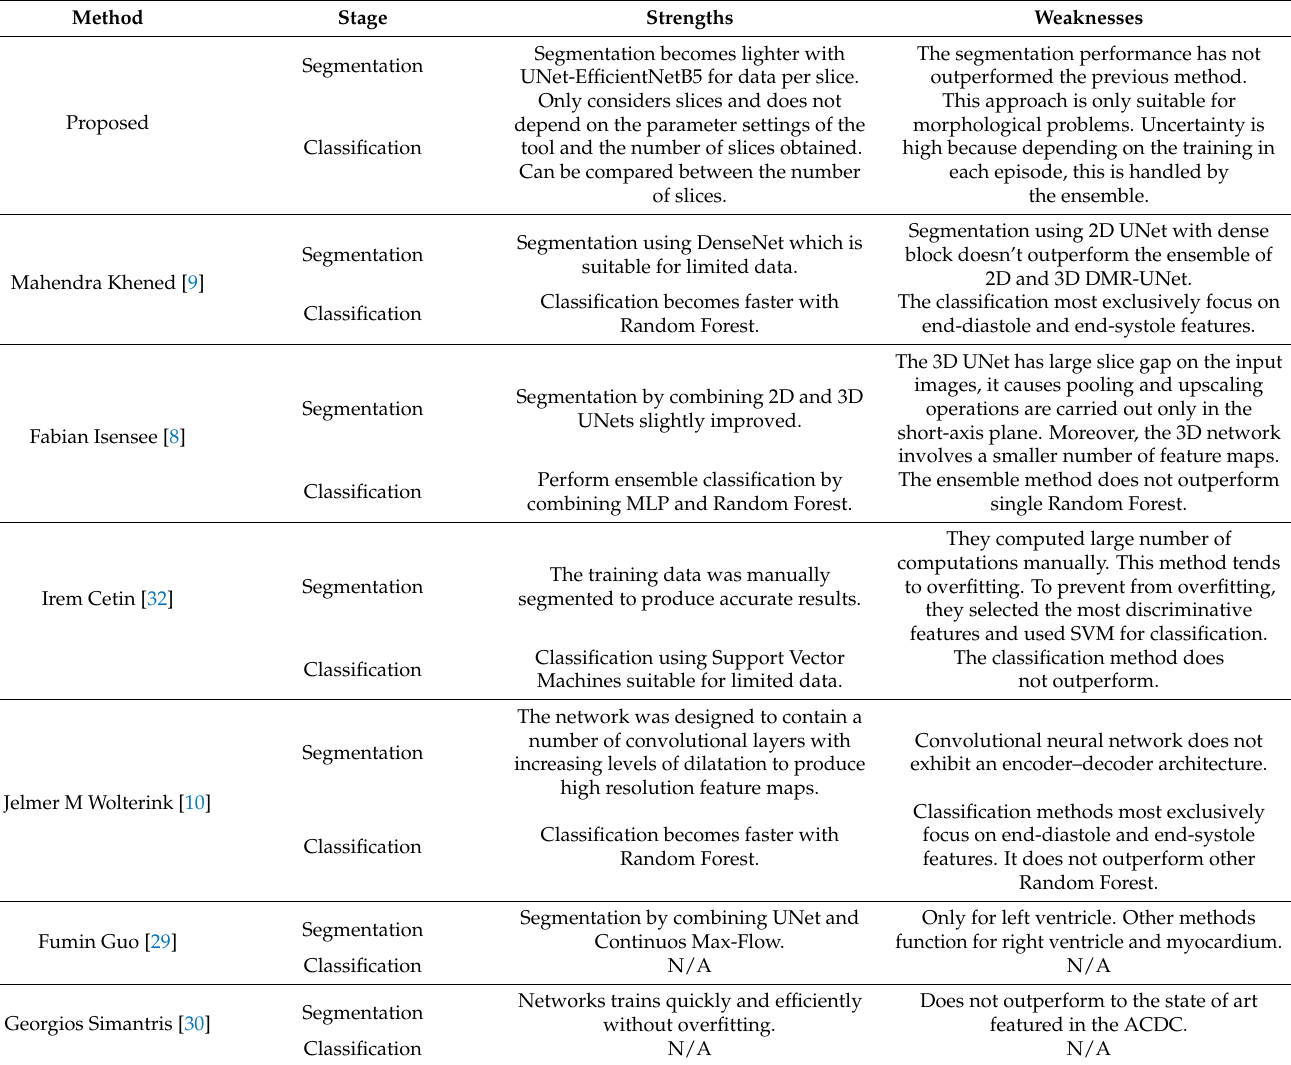
Table 8. Strengths and weaknesses of the proposed method compared to previous